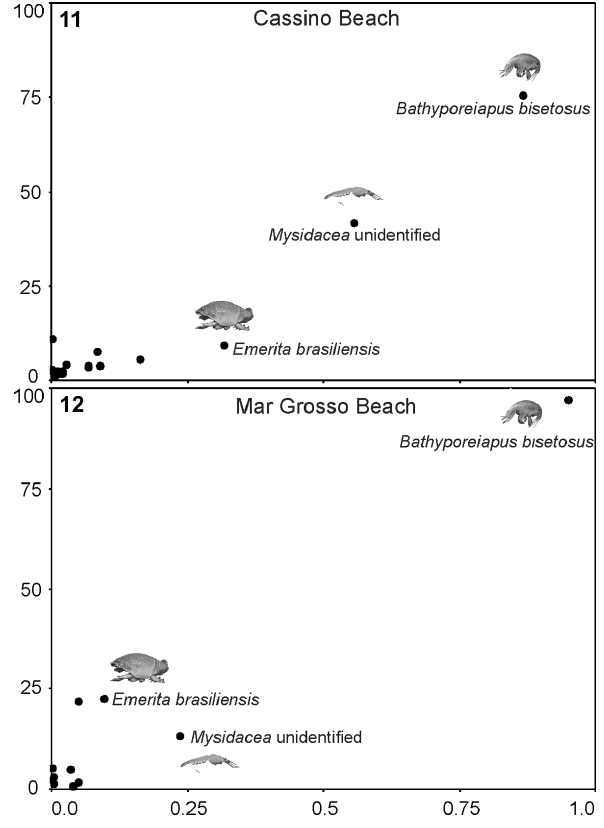
Figures 11–12. Feeding strategy diagram for individuals of Oncop- terus darwinii caught at both sites: (11) Cassino; (12) Mar Grosso). The prey-specific abundance plotted against the frequency of occurrence of food items for O. darwinii